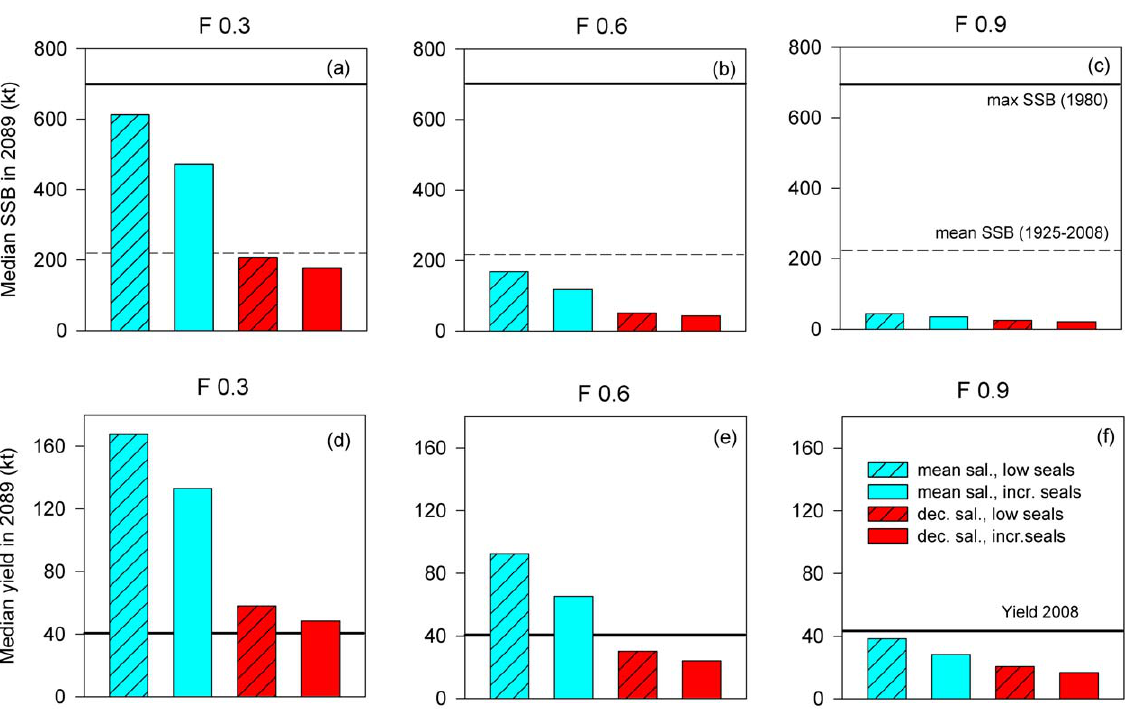
Figure 2. Simulated cod biomass and fishery yield in the 21 st century in the eastern Baltic Sea for different combinations of exploitation, climate change and seal predation. Panels a–c: Median projected cod spawner biomass in the eastern Baltic Sea (ICES Subdivisions 25–32) in 2089 estimated for different scenarios of exploitation level (F), seal predation and climate change (salinity decrease). The long- term (1925–2008) mean spawner biomass (220,000 t; solid horizontal line [37]) and the maximum historically observed spawner biomass since the 1920s (dashed horizontal line; [37,52]) are shown for comparison. Panels d–f: Median projected yields of cod to the fishery in the Baltic Sea (ICES Subdivisions 25–32) in 2089 estimated for different scenarios of exploitation (F), seal predation and climate change (salinity decrease). Also shown for comparison is the yield in 2008 (solid horizontal line). doi:10.1371/journal.pone.0018998.g002 The projected development of the eastern Baltic cod population depends strongly on all three forcings considered. The status quo